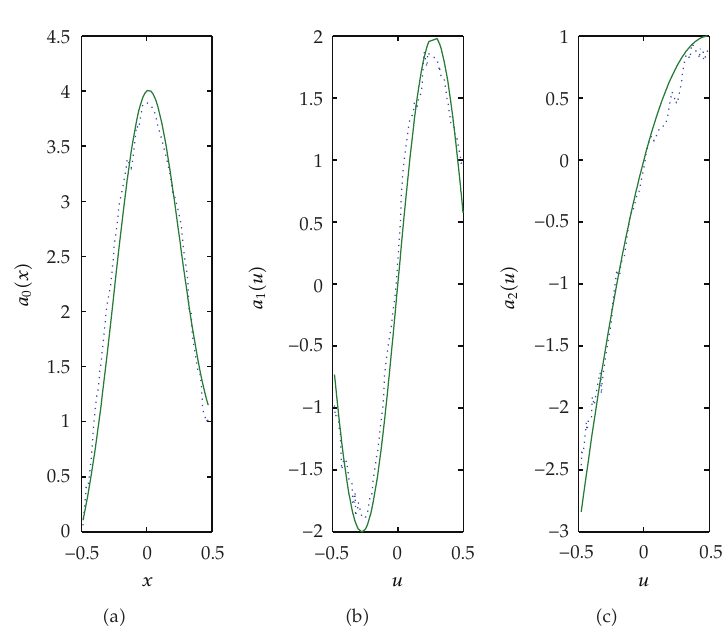
Figure 2: Simulation results, for example. Dotted curves are L 1 estimators; solid curve are the true curves.